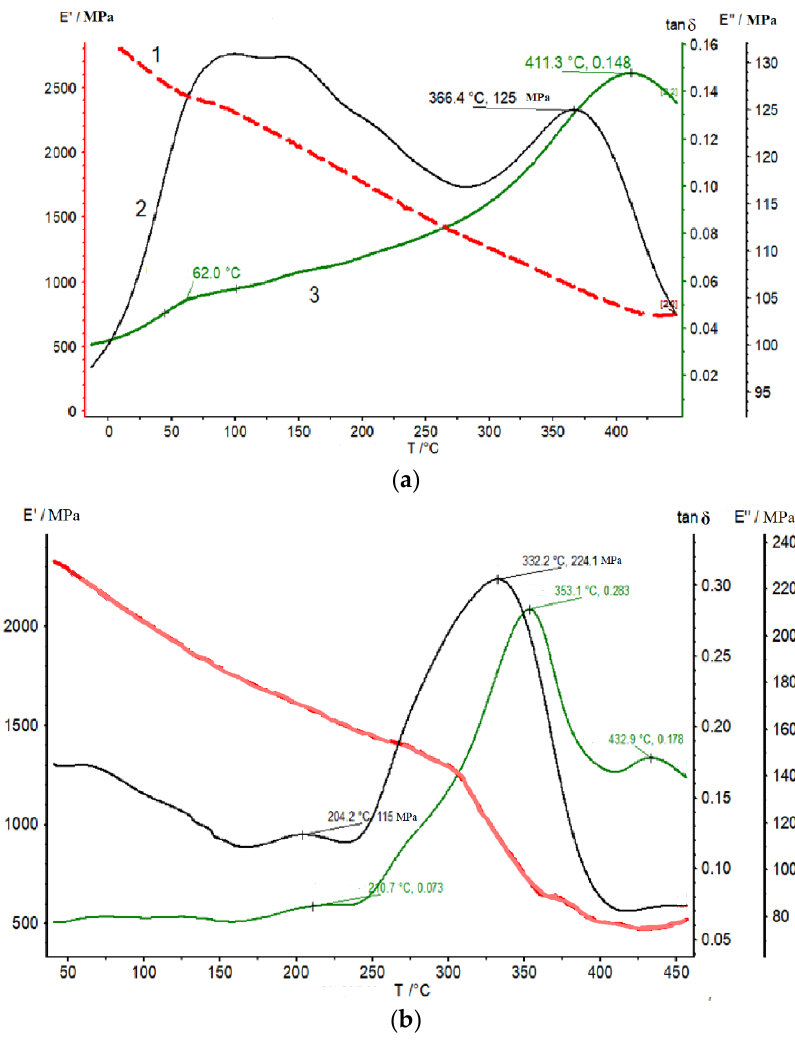
Figure 4. DMA curves: ( а ) film of poly(urethane-imide) thermalized at 300 0 С for 30 min after soaking it for 48 h at 20 °C in a mixture of hydrochloric acid (90% vol.) and acetic acid (10% vol.); ( b ) laboratory sample of poly(4,4 ′ -oxydiphenylene)pyromellitimide film. Temperature dependence of accumulation modulus E’ (red curve), loss modulus (blue curve) and tan δ (green curve).